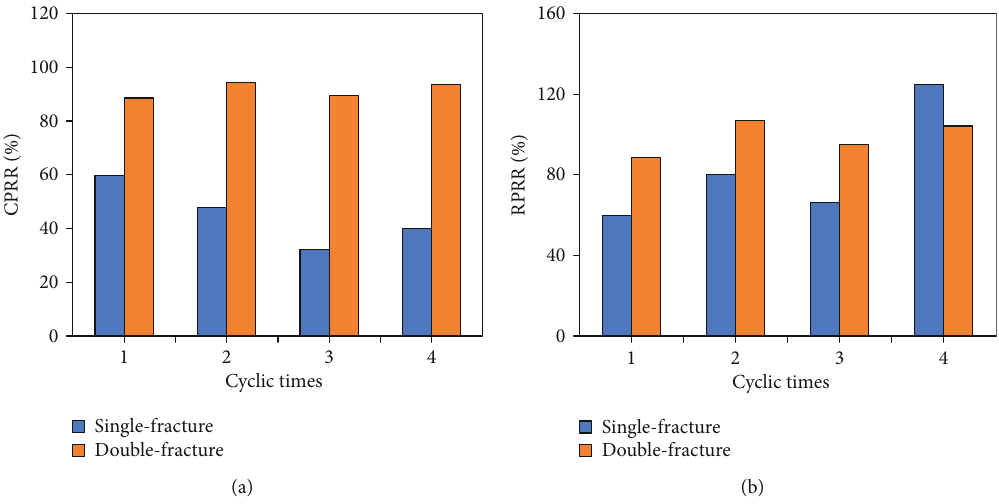
Figure 11: The permeability recovery at di ff erent cycles: (a) cumulative permeability recovery rate; (b) relative permeability recovery